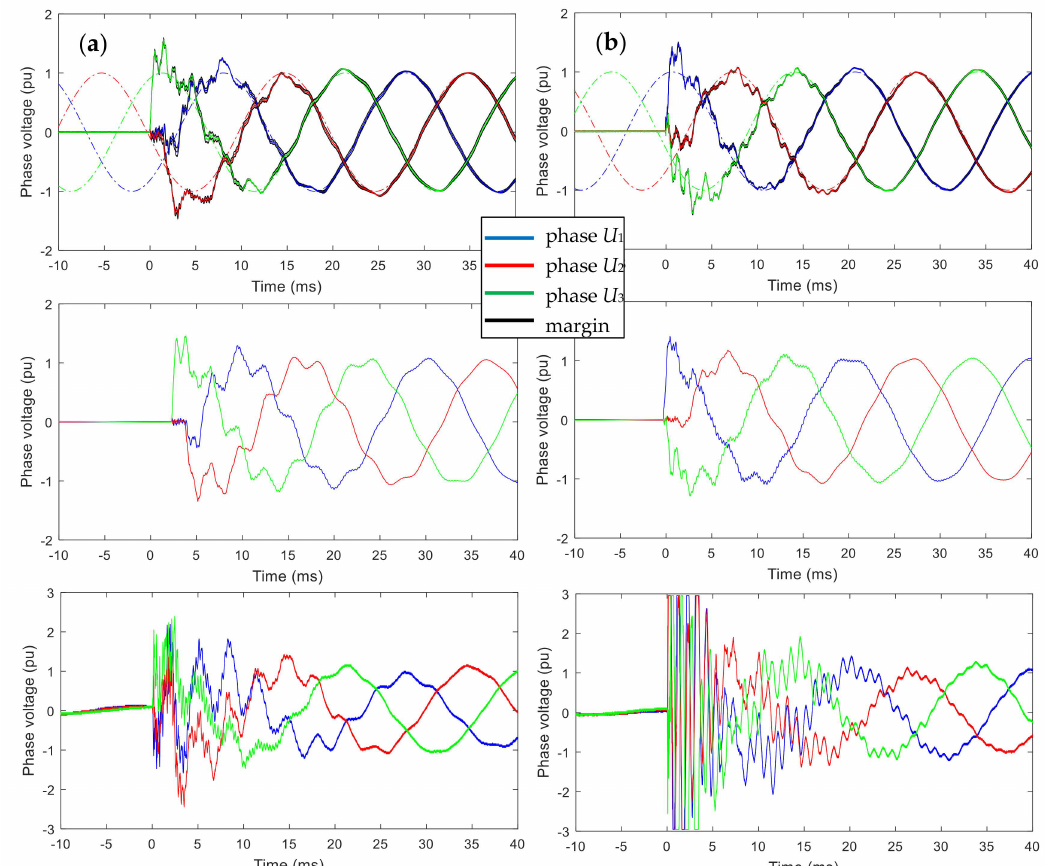
Figure 7. Comparison of results from D / I methodology (top figures, black lines indicate the uncertainty margins caused by uncertainty in decoupling), PSCAD simulation (middle figures) and RC-divider results (bottom figures): ( a ) Energization from substation connected by 4.4 km overhead line to the transition point; ( b ) Energization from substation connected via 6.8 km overhead line. For both switching events the high frequency oscillations are overrepresented in the divider measurement as compared to both D / I measurement and